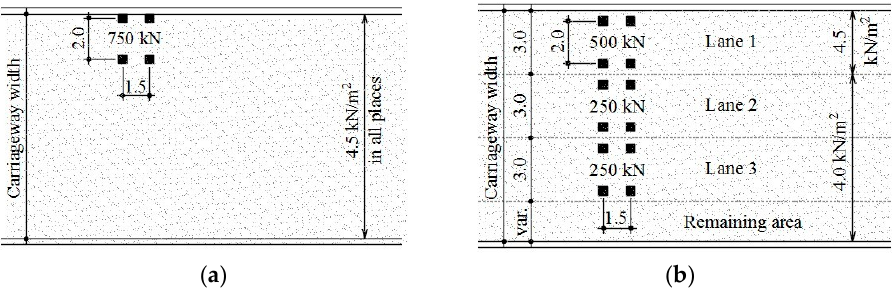
Figure 8. Plan view of the proposed load models: ( a ) load model 1; ( b ) load model 2. Units: m.